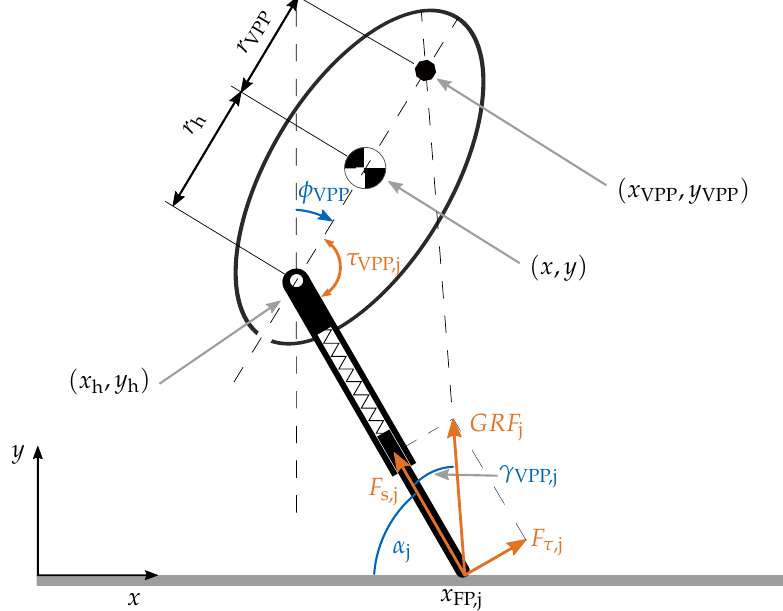
Figure 3. The hip torque τ VPP,j generates a force F τ ,j orthogonal to the leg axis that redirects the GRFs GRF j into the VPP. γ VPP,j represents the angle between the leg and the connection between the foot point x FP,j and the VPP ( x VPP , y VPP ) . The orientation of the trunk is defined by φ VPP . For the sake of clarity, only one leg ( j = { L , R } ) is shown here. Figure adapted from [23] (reprinted with permission from [23], 2020